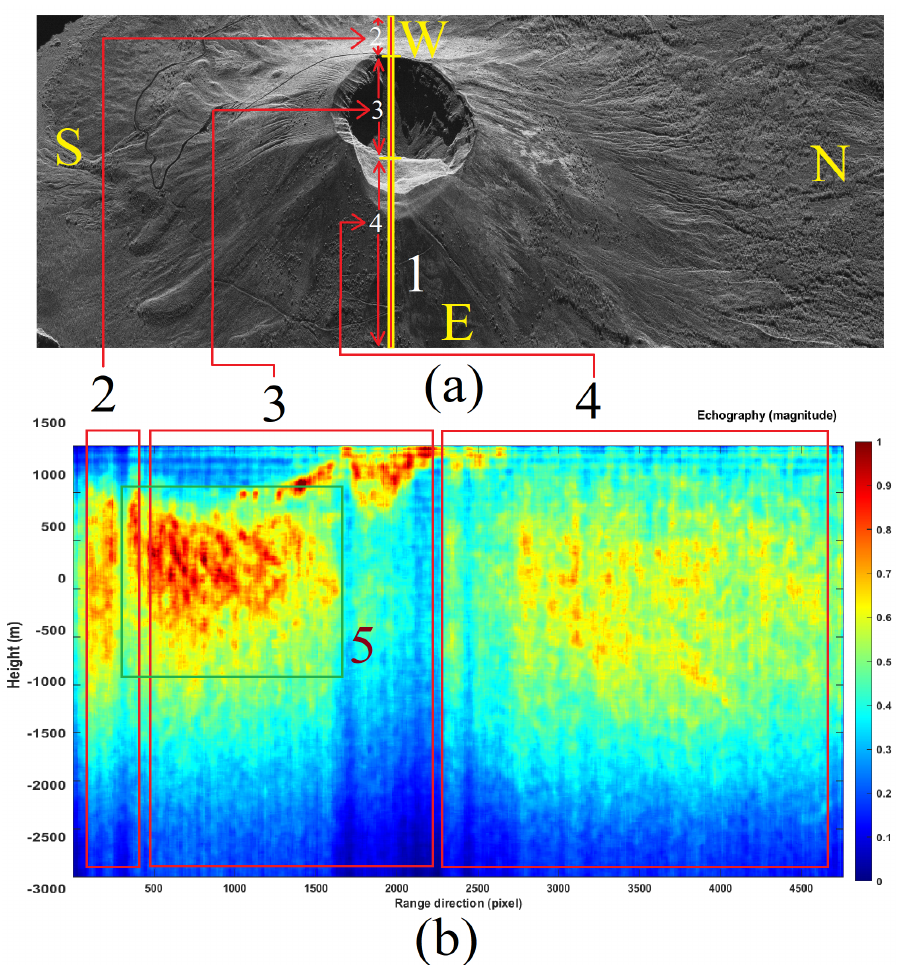
Figure 14. Tomographic results and analysis. ( a ) SLC SAR data of Vesuvius. ( b ) Tomographic results and